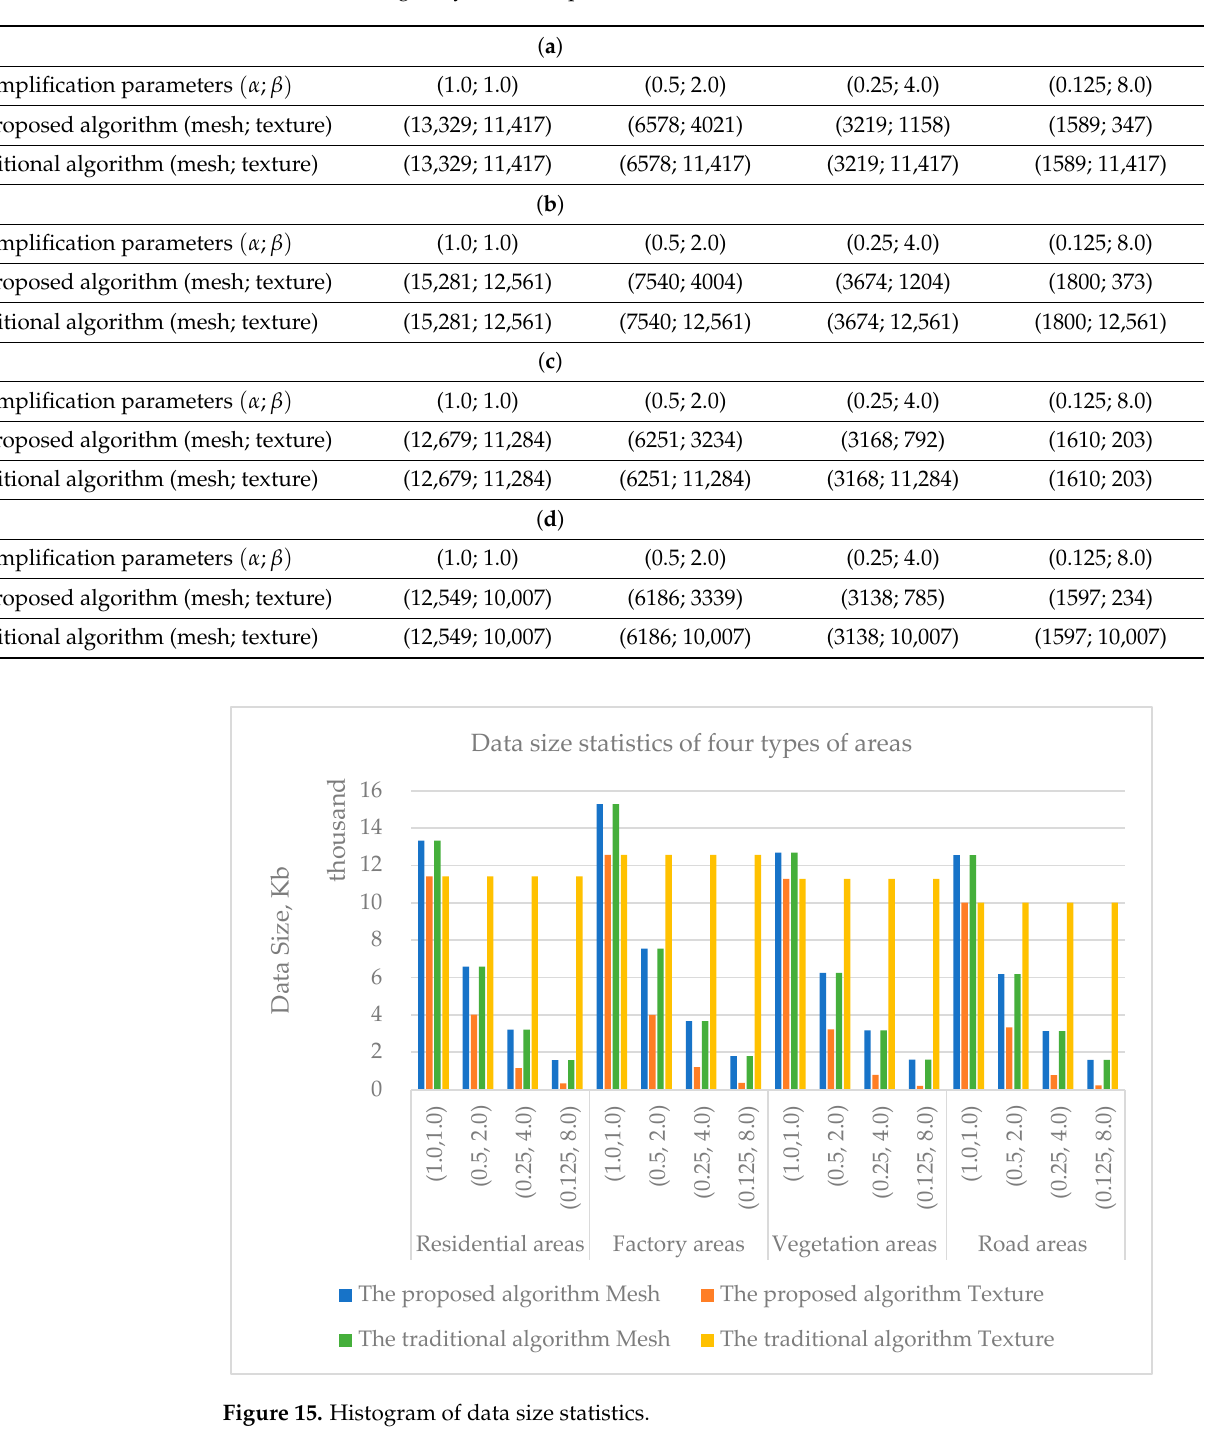
Table 2. Data size statistics. The data size (mesh, texture) after the proposed algorithm and the traditional algorithm are simplified under different simplification parameters are counted, and the unit is kb. ( a ) Residential areas. ( b ) Factory areas. ( c ) Vegetation areas (farmland for example). ( d ) Road areas (highways for example).